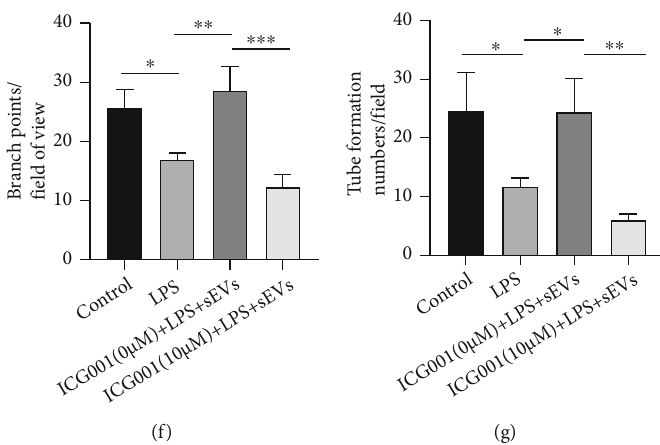
Figure 5: Proangiogenic potential of CFs enhanced by sEVs was associated with β -catenin. (a) β -Catenin expression in CFs was detected by western blotting after Angptl4 in CFs and in hucMSCs was knocked down with siRNA. (b) After using the β -catenin inhibitor ICG001 (0, 5, 10, and 15 μ M), primary CFs were treated with LPS (100ng/mL) and LPS+sEVs (200 μ g/mL) for 24h and supernatants were collected to culture HUVECs. The proliferation of HUVECs was measured by the CCK-8 assay. (c) The migration of HUVECs was measured by the Transwell migration assay. Scale bar: 100 μ m. (d) Quantitative analysis of migrated cells. (e – g) Tube formation ability of HUVECs was evaluated by the tube formation assay (e). Scale bar: 500 μ m. Quantitative analysis of the total branching points (f) and tube formation numbers (g). ∗ P < 0 : 05 , ∗∗ P < 0 : 01 , ∗∗∗ P < 0 : 001 , and ∗∗∗∗ P < 0 : 0001